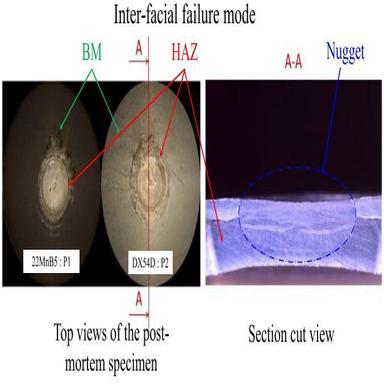
Inter-facial failure mode of three-sheet spot weld for shear mode (ψ = 90∘ ).